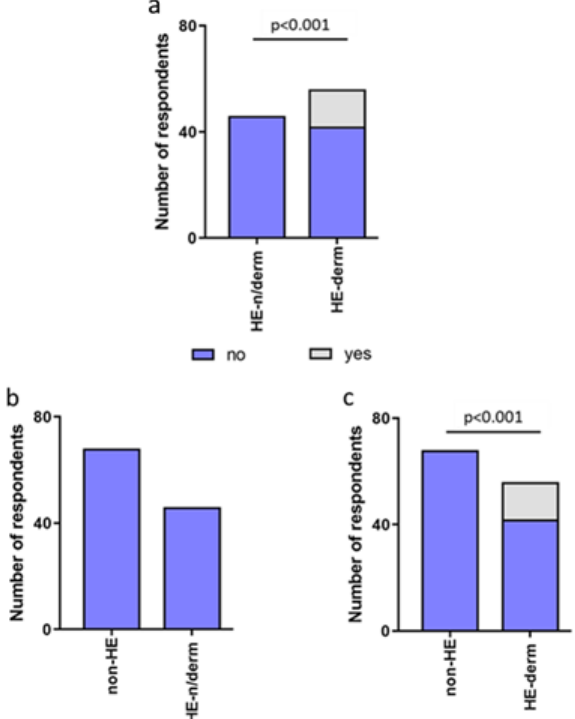
Figure 16. Changes in treatment in the study groups during the pandemic: ( a ) HE-n/derm vs. HE-derm; ( b ) non-HE vs. HE-n/derm; ( c ) non-HE vs. HE-derm.